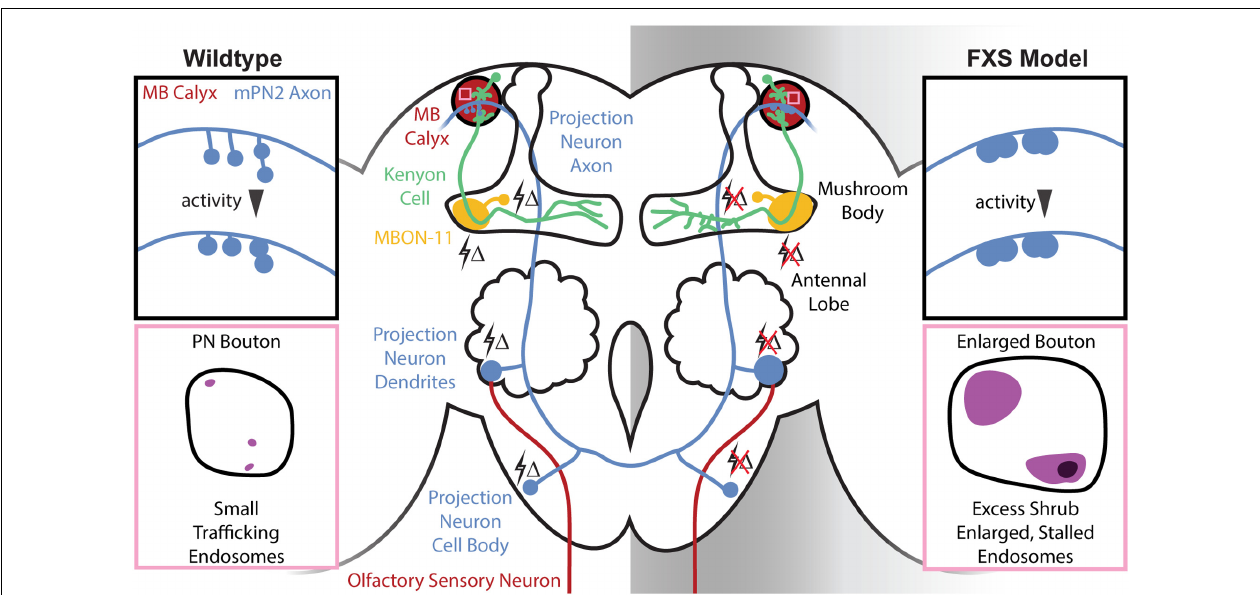
FIGURE 1 | Central brain mushroom body (MB) circuit defects in the Drosophila Fragile X syndrome (FXS) model. Schematic of the Drosophila central brain olfactory circuitry comparing wildtype (Left) and the FXS disease model (Right). Olfactory sensory neurons (OSNs) (red, bottom) expressing specific odorant receptors converge in antennal lobe (AL) glomeruli to synapse on projection neurons (blue, middle). Projection neurons output to the MB calyx (red, top) to synapse on Kenyon cells (KCs) (green), which in turn project to MB axonal lobes to synapse on MB output neurons [e.g., MB output neuron type 11 (MBON-11, yellow)]. Changes in olfactory sensory experience (lightning bolts (cid:49) ) drive activity-dependent synaptic remodeling throughout this circuit in the early-use critical period, which fails in the FXS condition. Top insets (black boxes): schematic of MB calyx in wildtype and the FXS model. Projection neuron synaptic termini are normally subject to activity-dependent remodeling, but this is absent in the FXS model. The resulting collapsed synaptic architecture with enlarged boutons is phenocopied with strong activity in wildtype. Bottom insets (pink boxes): schematic of single projection neuron synaptic boutons in the wildtype and FXS model MB calyx. The endosomal sorting complex required for transport III (ESCRTIII) core component Shrub normally mediates rapid endocytic membrane trafficking within the PN synaptic boutons, but the FXS model displays an increased number of trafficking-arrested, enlarged synaptic